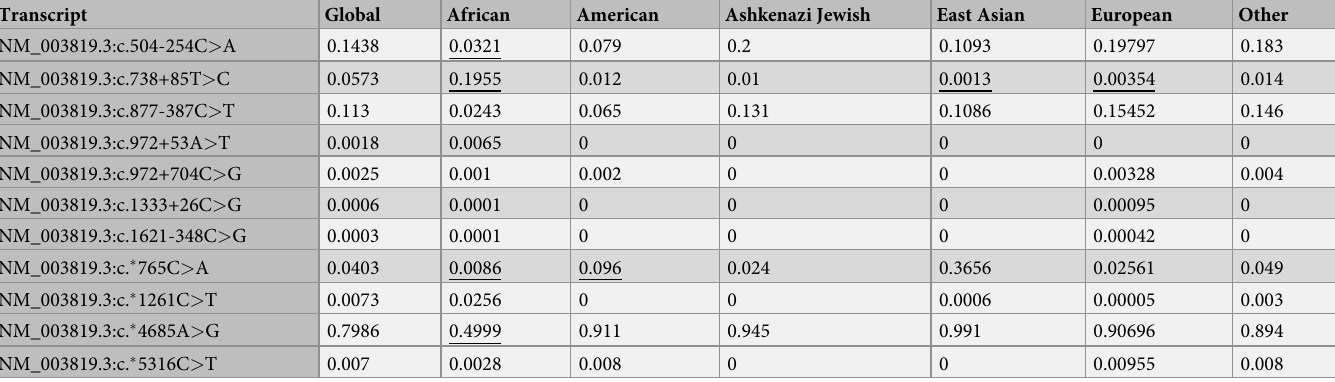
Population frequencies are taken from dbSNP. Populations with greater distance from global distribution are